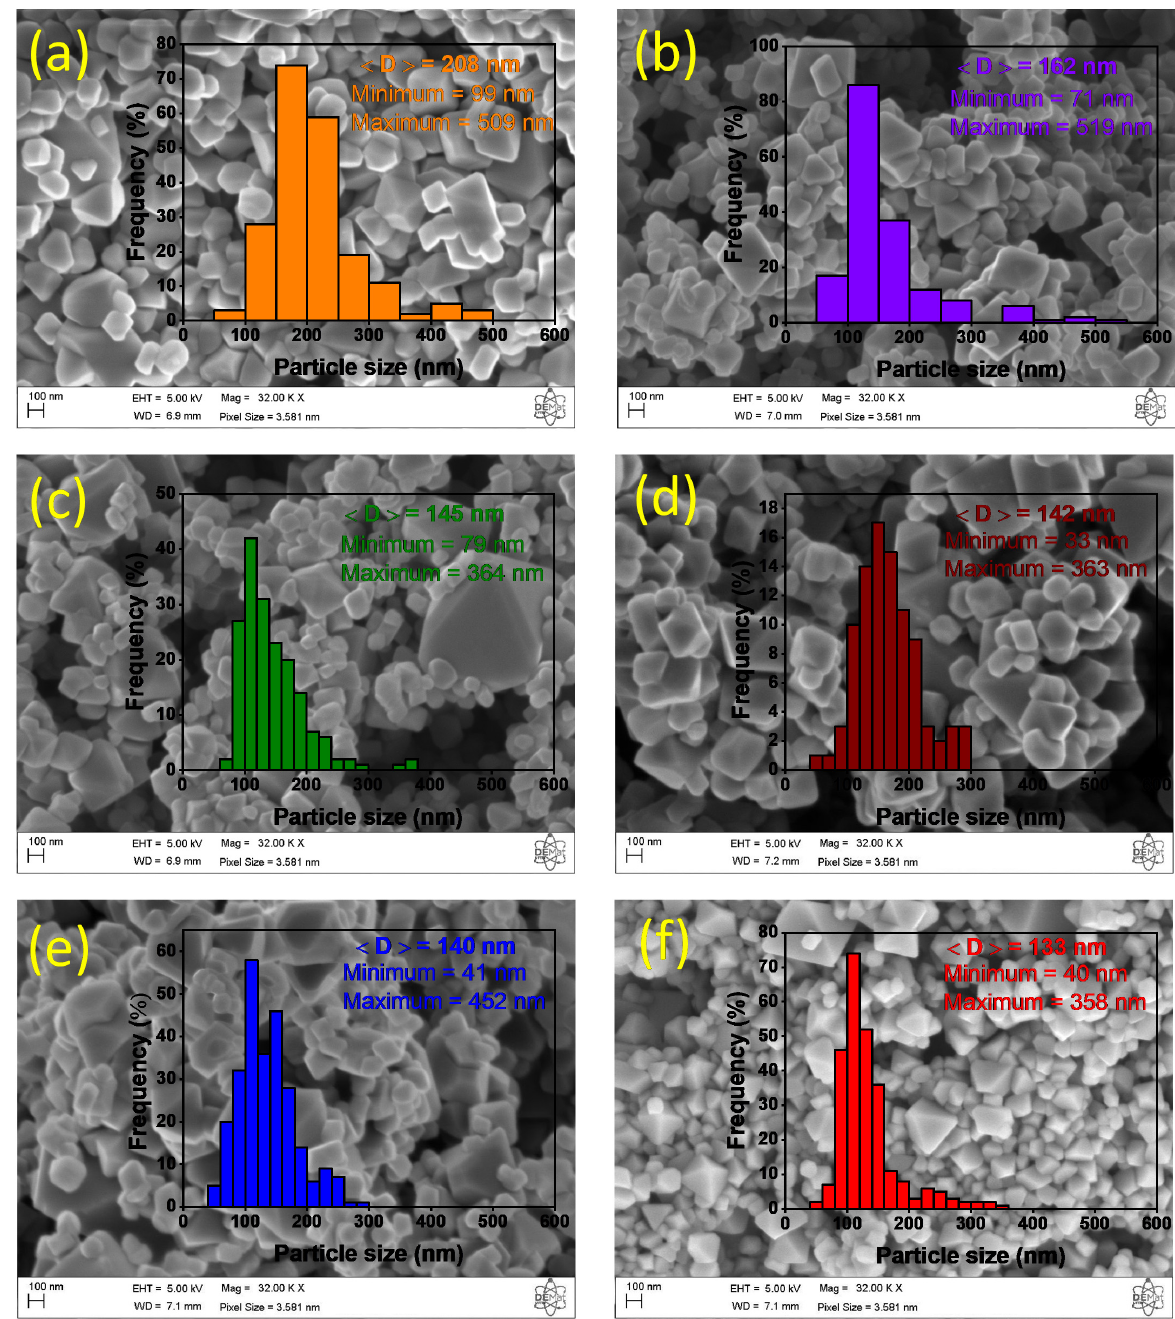
Figure 4. FESEM images and particle size distribution of Mn X Co 3-X O 4 (0 ≤ X ≤ 1) samples ( a ): X = 0.0, ( b ) X = 0.2, ( c ) X = 0.4, ( d ) X = 0.6, ( e ) X = 0.8, and ( f ) X = 1.0. ( b ) X = 0.2, ( c ) X = 0.4, ( d ) X = 0.6, ( e ) X = 0.8, and ( f ) X =